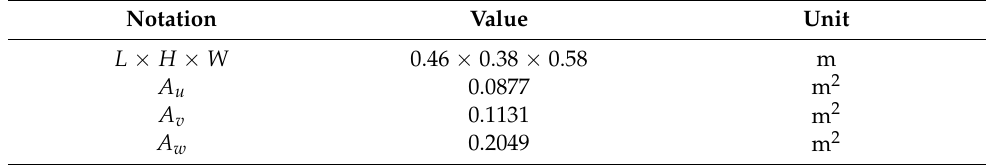
Table 5. Overall dimensions and projected areas of the BlueROV2 heavy